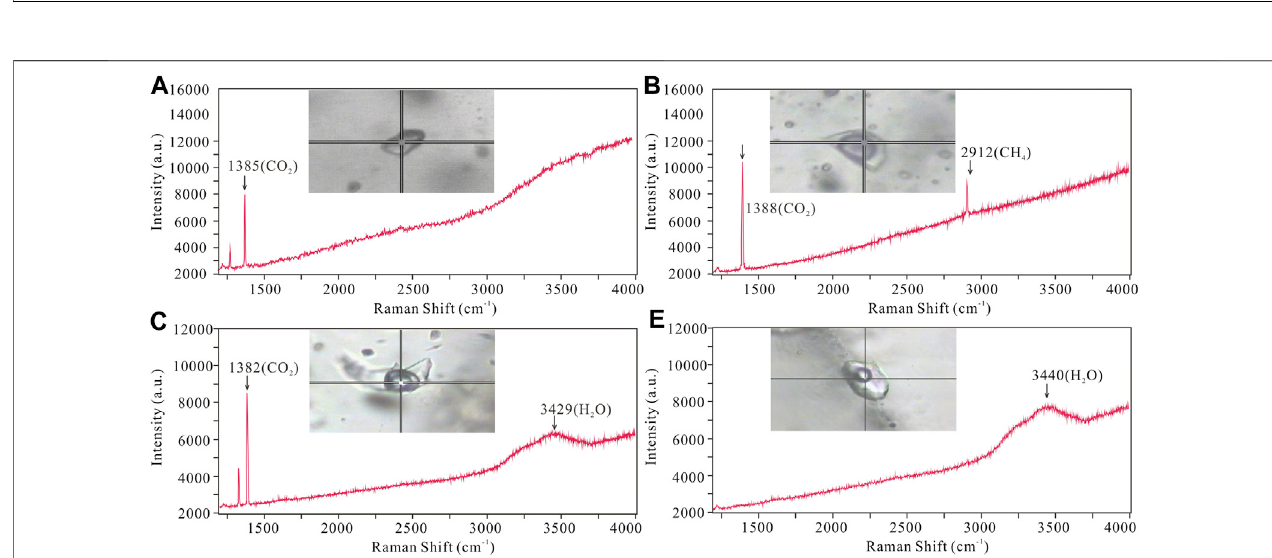
FIGURE 6 | Representative Raman spectra of FIs from the Jinba gold deposit. (A) C – type FI showing major CO 2 peak; (B) Two phase LC – type FI showing major CO 2 with minor CH 4 peak; (C) Three LC – type FI showing major CO 2 peaks; (D) LV – type FI showing major H 2 O peak.